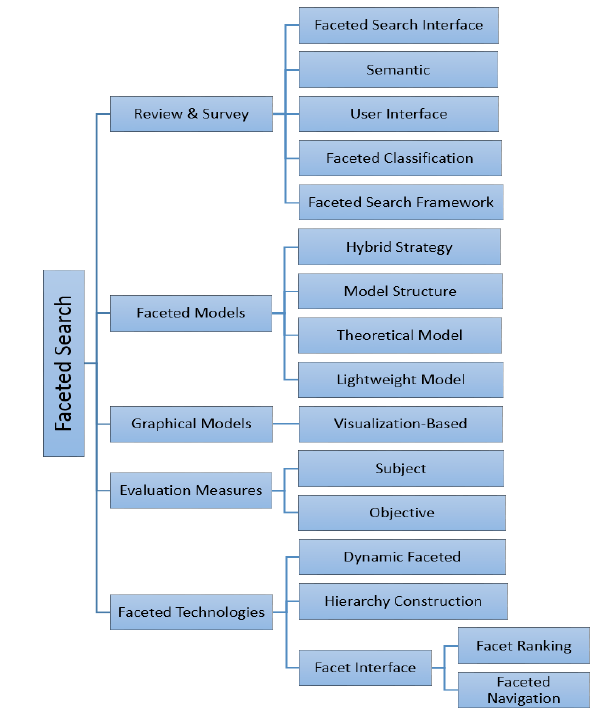
Figure 6. Taxonomy of faceted